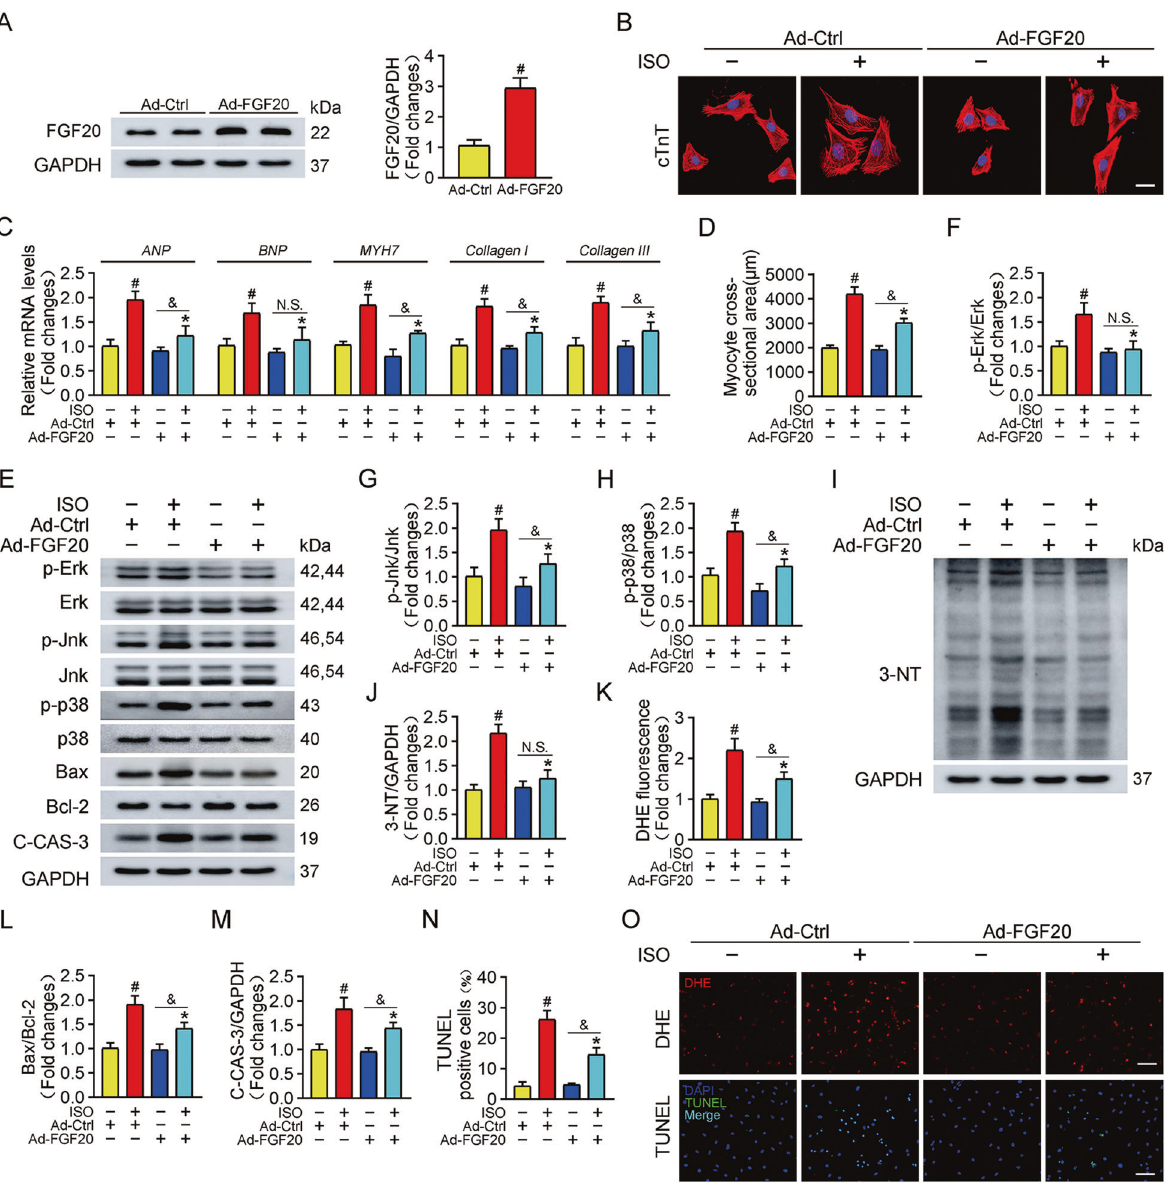
Fig. 2 FGF20 overexpression protects against ISO-induced cardiomyocyte hypertrophy in vitro. A Western blot was performed and quantitatively analyzed to determine the protein levels of FGF20 in NRCMs transfected with adenoviruses expressing FGF20 (Ad-FGF20) and or empty control vector (Ad-Ctrl). B Representative immuno fl uorescence (red for cTnT, blue for DAPI) and quantitative analysis of myocyte surface area in NRCMs transfected with Ad-Ctrl or Ad-FGF20 in the presence or absence of ISO. Scale bar = 40 μ m. C RT-qPCR analysis of the mRNA levels of hypertrophic marker genes ( ANP, BNP , and MYH7 ) and fi brosis marker genes ( Collagen I and Collagen III ) in NRCMs transfected with Ad-Ctrl or Ad-FGF20 in the presence or absence of ISO. D Quanti fi cation of myocyte surface area in B . E Western blot was performed to determine the protein levels of p-Erk, Erk, p-Jnk, Jnk, p-p38, p38 (MAPK signaling pathway), Bax, Bcl-2, and C-CAS-3 (Cleaved caspase 3) in NRCMs transfected with Ad-Ctrl or Ad-FGF20 in the presence or absence of ISO. F – H Quantitative analysis of expressions of p-Erk, Erk, p-Jnk, Jnk, p-p38, and p38 in E . I , J Western blot was performed and quantitatively analyzed to determine the protein levels of 3-NT (a marker of oxidative stress-induced protein damage) in NRCMs transfected with Ad-Ctrl or Ad-FGF20 in the presence or absence of ISO. K Quantitative analysis of the level of ROS in O . L , M Quantitative analysis of expressions of Bax, Bcl-2, and C-CAS-3 in E . N Quantitative analysis of cardiomyocytes apoptosis in O . O DHE staining was performed to detect intracellular ROS (Scale bar = 80 μ m) and TUNEL assay was performed to detect cell apoptosis (Scale bar = 60 μ m), in NRCMs transfected with Ad-Ctrl or Ad-FGF20 in the presence or absence of ISO. n = 5 per group, # P < 0.05 versus Ad-Ctrl group, * P < 0.05 versus ISO group, & P < 0.05 versus Ad-FGF20 group. Data represent means ± SEM, Two-tailed Student ’ s t apoptotic factor Bcl-2 (Bax/Bcl-2) and the protein level of cleaved- caspase-3 (C-CAS-3). FGF20 overexpression signi fi cantly mitigated the effect of ISO on these proteins (Fig. 2E, L, M). Moreover, we overexpression (Fig. 2K, O). Cardiomyocyte apoptosis is a mediator also observed a signi fi cant increase in the number of TUNEL- of the pathogenesis of pathological cardiac hypertrophy. ISO positive apoptotic cells in ISO-treated cardiomyocytes, which was